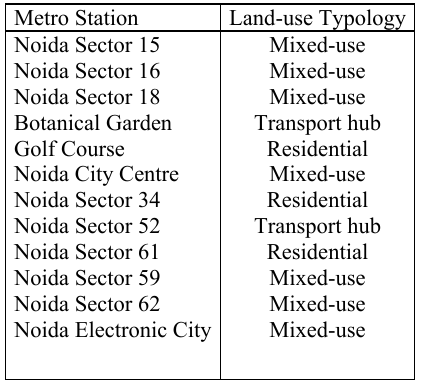
Figure 2 . ODK Aggregate Server project screen showing data collected from the respondents.